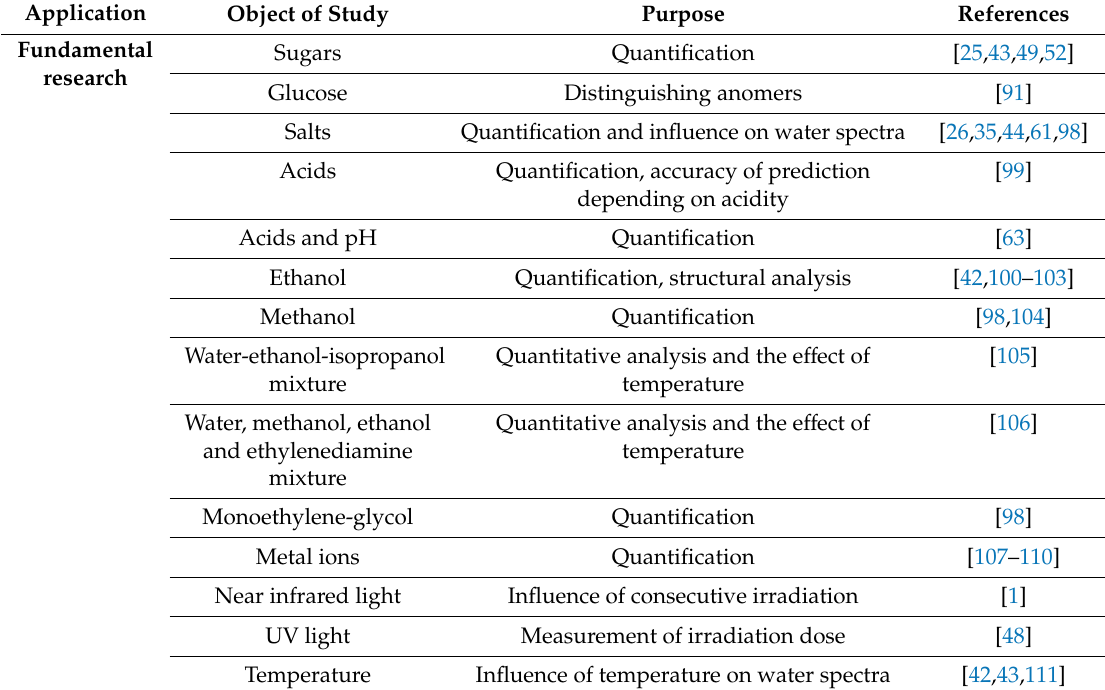
Table 2. Aquaphotomics contribution: from fundamental research to various